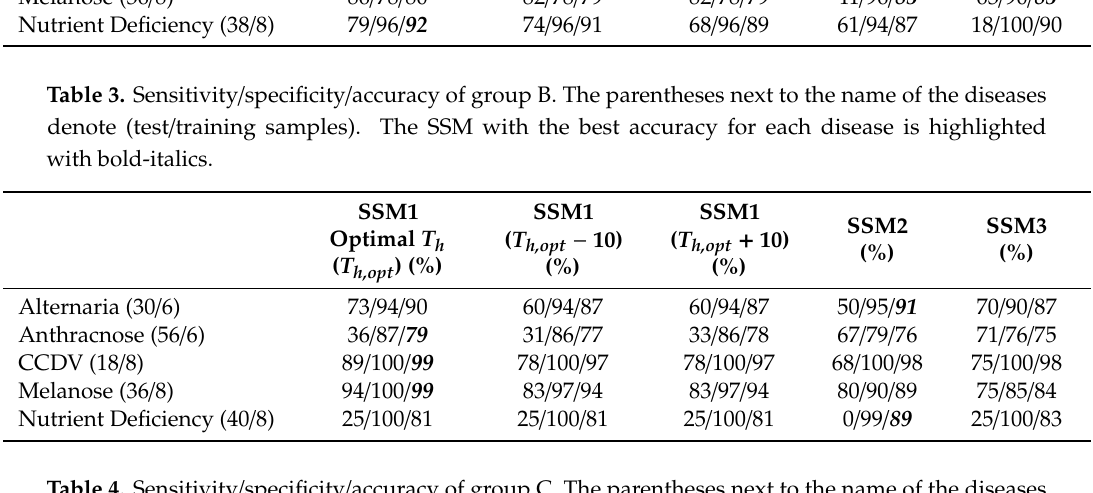
Table 4. Sensitivity / specificity / accuracy of group C. The parentheses next to the name of the diseases denote (test / training samples). The SSM with the best accuracy for each disease is highlighted with